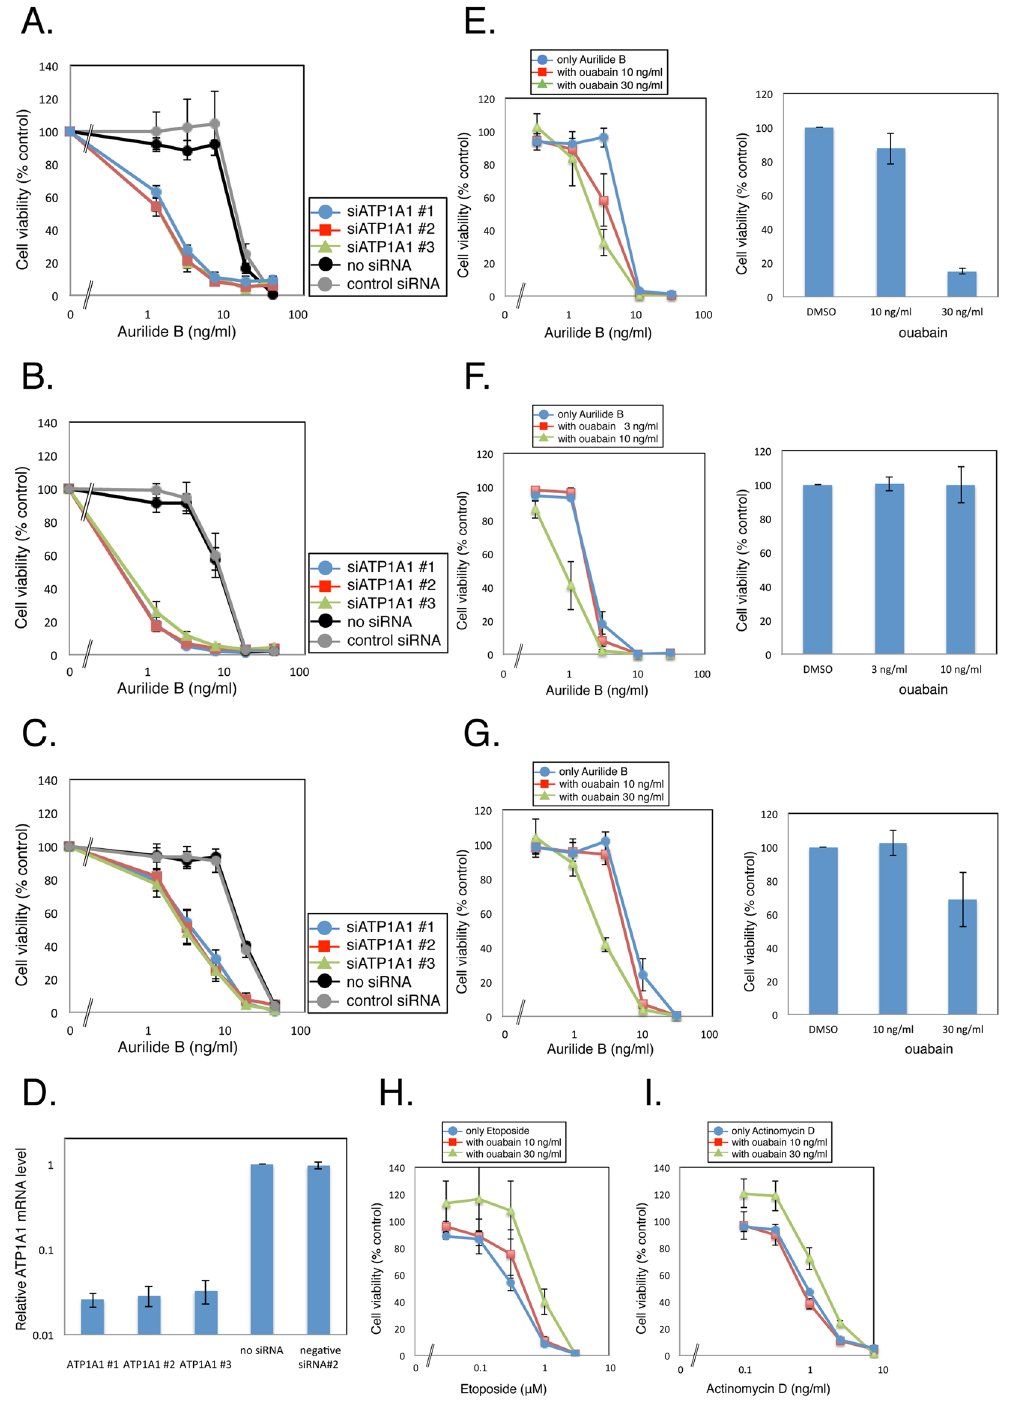
Figure 4. Effect of ATP1A1 inhibition on the sensitivity to aurilide B. ( A – C ) HeLa S3 ( A ), A549 ( B ) and HT-29 ( C ) cells were transfected with three independent siRNAs against ATP1A1, and then cultured for 2 days in the presence of various concentrations of aurilide B. Cell viability was measured by WST-8 assay. ( D ) HeLa S3 cells transfected with siRNAs against ATP1A1 were harvested, and the ATP1A1 mRNA level was measured by qPCR. ( E – G ) HeLa S3 ( E ), A549 ( F ) and HT-29 ( G ) cells were treated for 4 days with the indicated concentrations of aurilide B in the presence of ouabain. Cell viability was measured by WST-8 assay. ( H , I ) HeLa S3 cells were treated for 4 days with the indicated concentrations of etoposide ( H ) and actinomycin D ( I ) in the presence of ouabain. Cell viability was measured by WST-8 assay. Data represent means ± SD from three independent